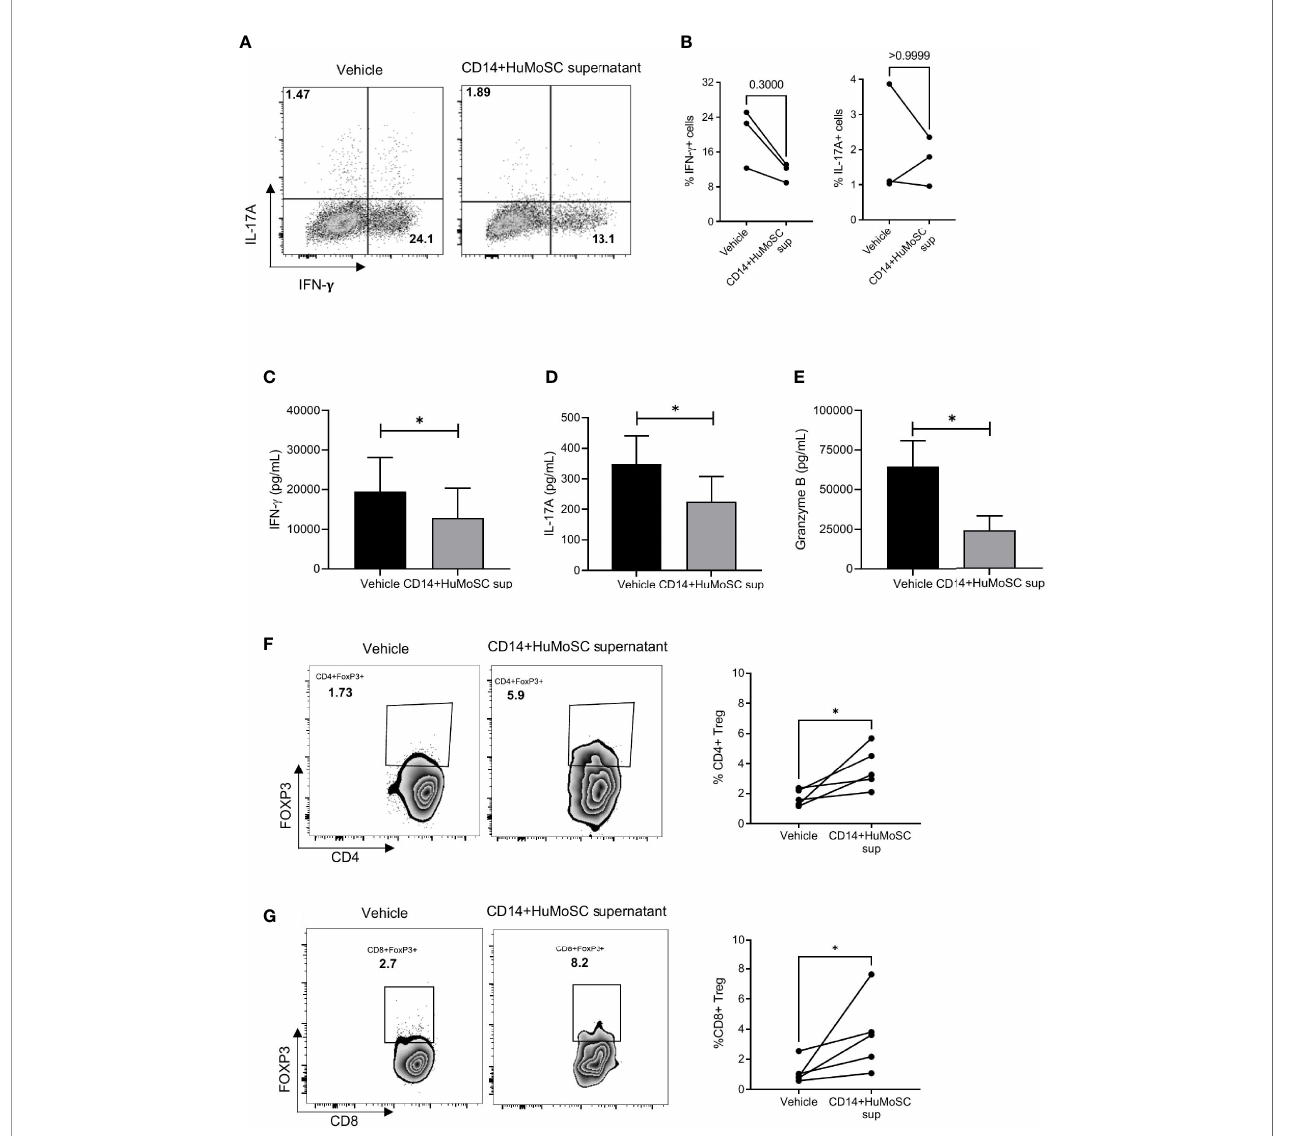
FIGURE 3 | Effect of CD14+HuMoSC supernatant on T cell polarization. (A-B) After 4 days of stimulation with anti-CD3/CD28 stimulation beads and incubation with either CD14+HuMoSC supernatant or physiological saline (vehicle), T cells were stimulated for 4h with PMA+ionomycine and brefeldin A and then stained for IFN- g , IL-4 and IL-17(A) Cytokine detection among CD4+ cells was performed by fl ow cytometry with BD LSR II and FlowJo software. (A) Dot plot from one representative experiment. (B) Percentage of IFN-g+ and IL-17A+ cells were calculated. Results of 3 independent experiments are shown. (C – E) . IFN- g , Granzyme B and IL-17A concentrations were measured in the culture of stimulated T cells treated with or without CD14+HuMoSC supernatant. Results of 3 independent experiments are shown. (F, G) . Induction of CD4 and CD8 Treg with CD14+HuMoSC supernatant. Left panels: representative dot plots. Right panels: results of 6 independent experiments are shown. Data are shown as mean ± SEM of representative experiments. Two-tailed Mann Whitney test *p ≤